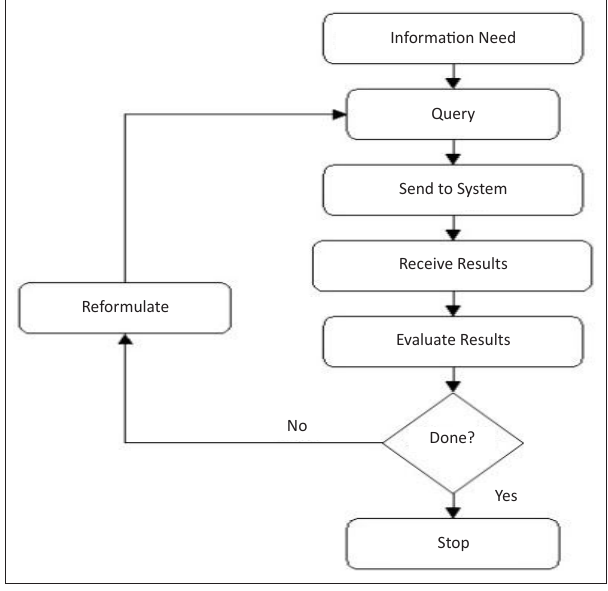
FIGURE 2: Standard information access